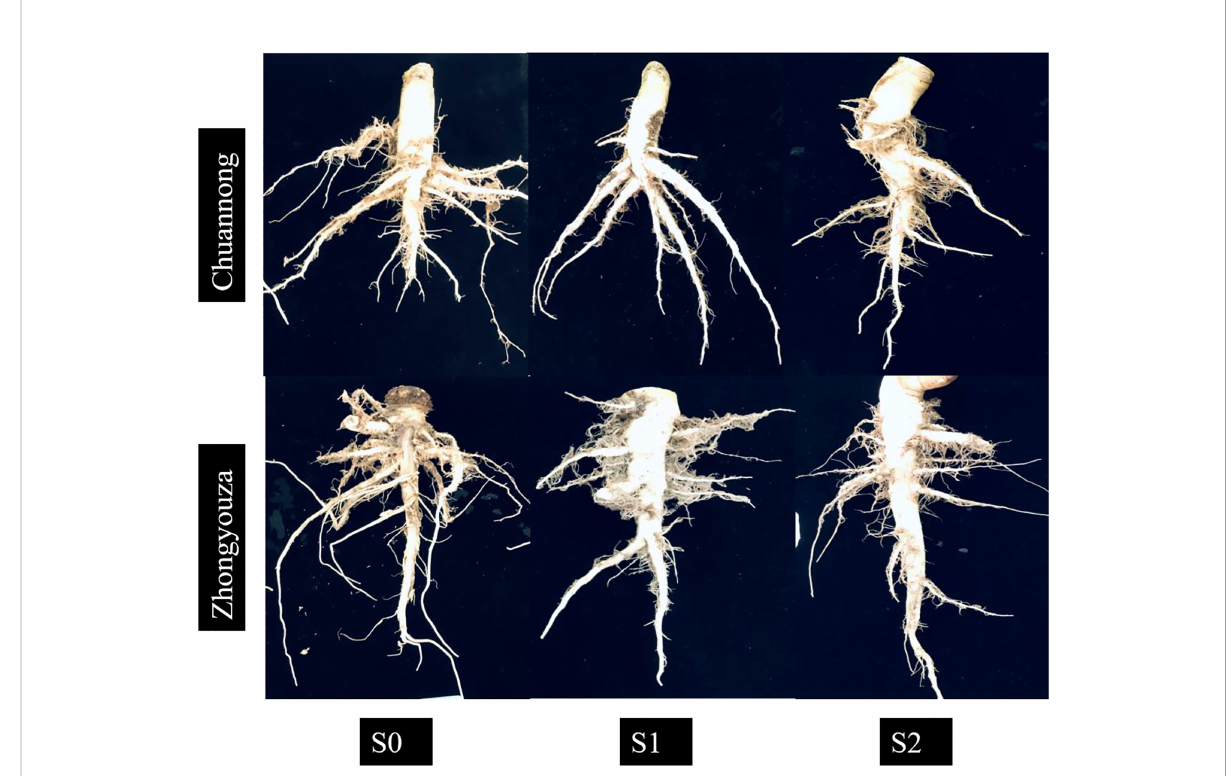
FIGURE 8 Effect of shading stress on the roots structure of two rapeseed